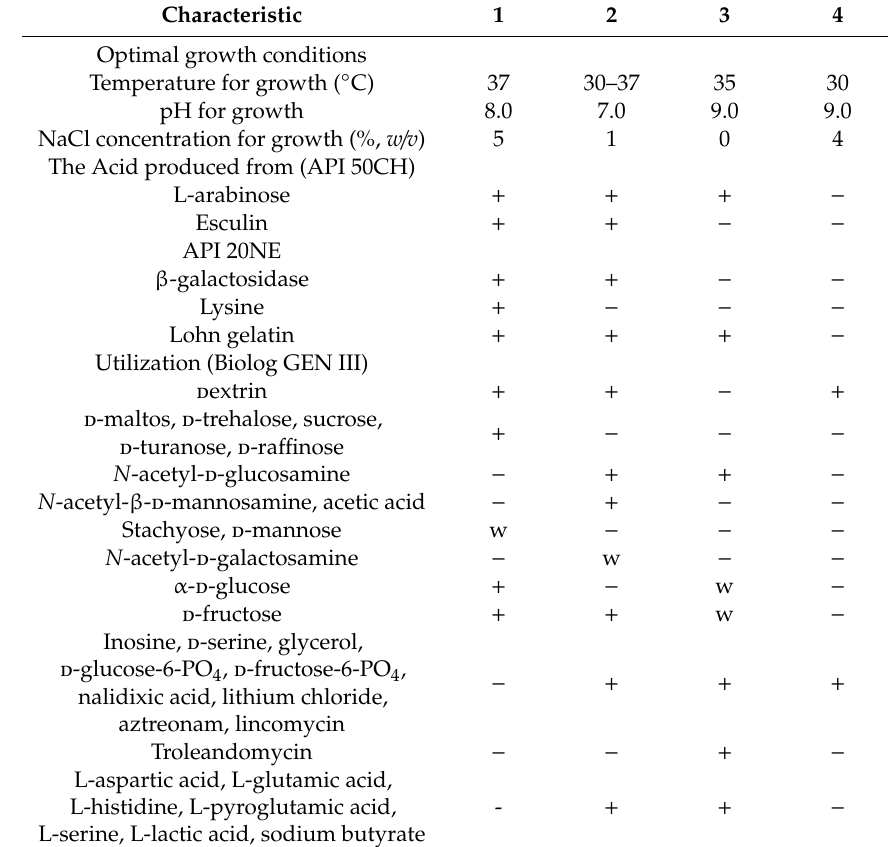
Table 1. Di ff erential phenotypic characteristics of strain 03113 T and closely related strains in the genus Bacillus . Characteristic